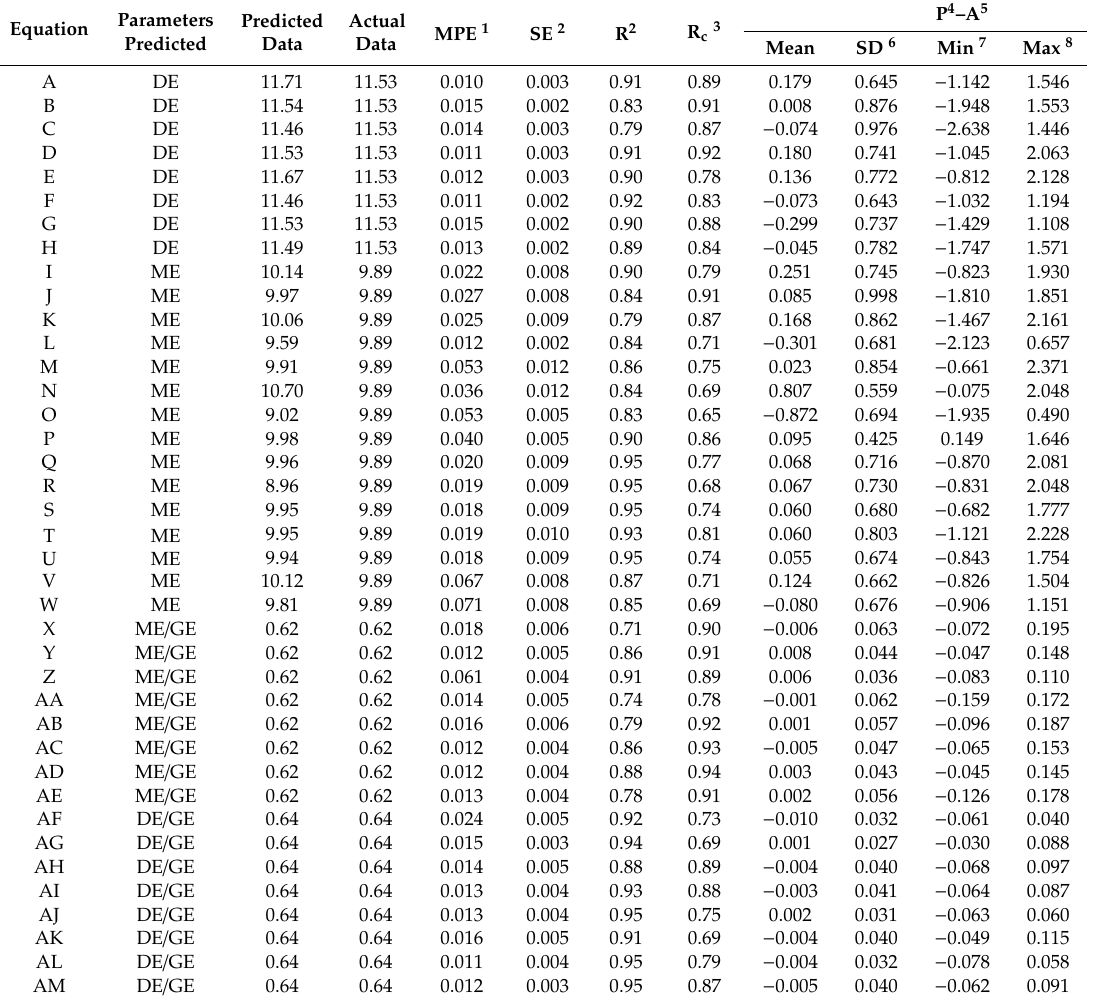
Table 7. Internal validation of equations developed from two-thirds of the whole data ( n = 44) using the remaining one-third of data ( n =